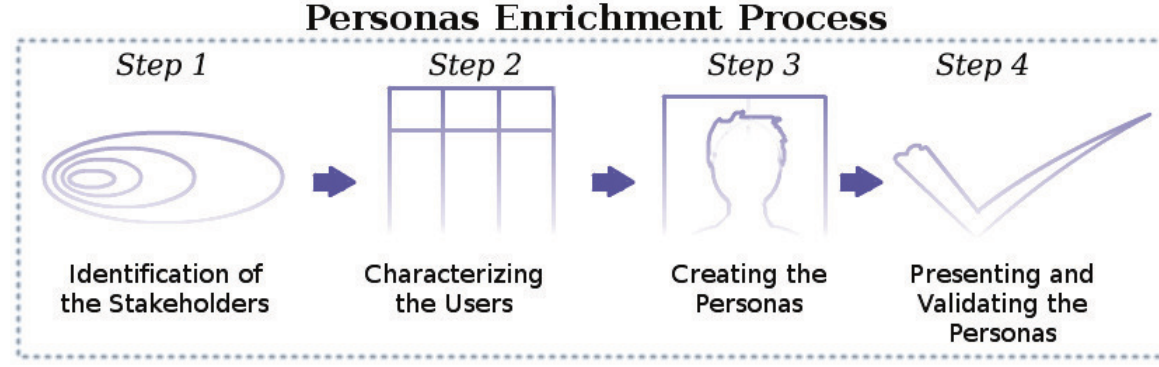
Fig. 1. Steps of the Personas Enrichment Process for the design of therapeutic applications.